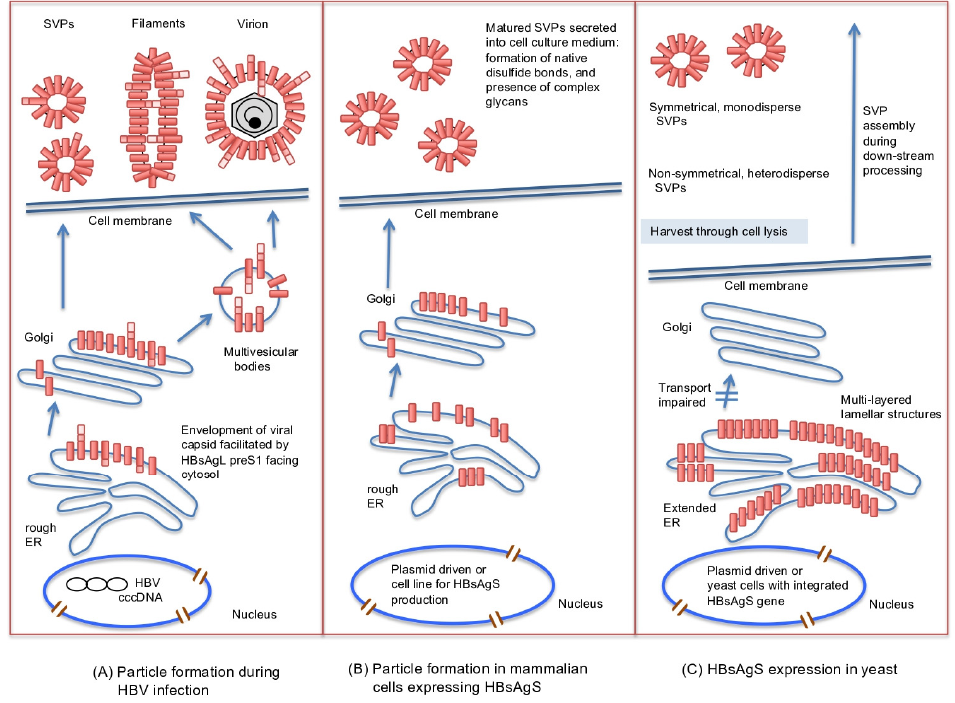
Figure 2. Illustration of HBsAg protein synthesis and assembly pathways during a natural infection ( A ), HBsAgS expression and assembly in mammalian cells in the absence of other viral gene products ( B ), or expressed in yeast ( C ). During a natural infection, virions and filaments are formed by budding from multivesicular bodies. The spherical subviral particles (SVPs) are produced and secreted through the endoplasmic reticulum (ER)-Golgi complex. The HBsAg subunits of the virions, filaments, and SVPs form intra- and intermolecular disulfide bonds, and are partially glycosylated (not shown) ( A ). Expression of the HBsAgS gene in mammalian cell lines leads to the formation of SVPs exclusively composed of HBsAgS permitting the formation of disulfide bonds and partial glycosylation (not shown) ( B ). HBsAgS protein expressed in yeast accumulates in the ER, causes an extended ER and forms multilayered lamellar structures. HBsAgS protein complexes are harvested from the cell lysate, and SVPs are assembled during down-stream processing ( C ). cccDNA: covalently closed circular